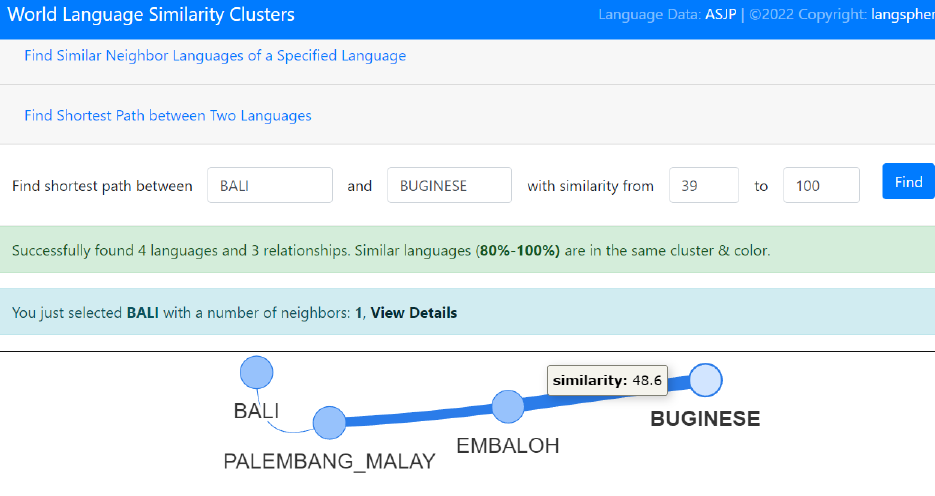
Figure 7. World Language Similarity Cluster (https://world.langsphere.org, accessed on 17 September